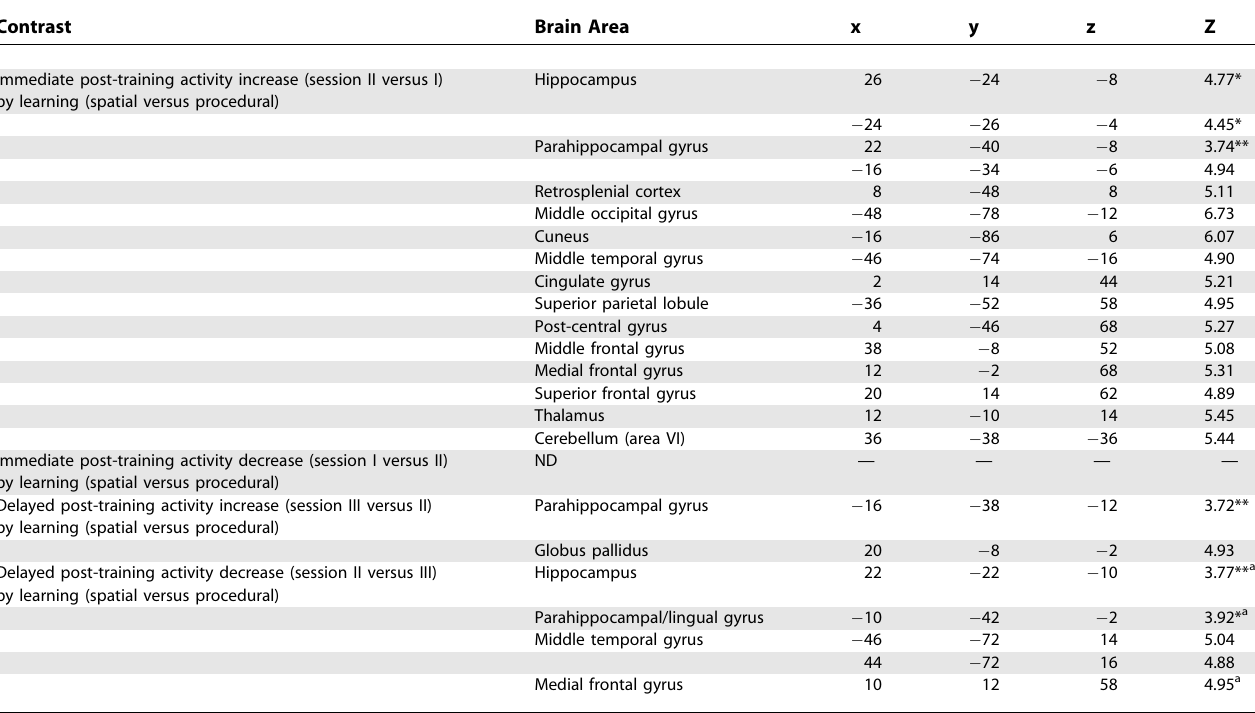
Table 1. Offline Activity after Spatial Learning Contrast Brain Area x y Immediate post-training activity increase (session II versus I) by learning (spatial versus procedural)